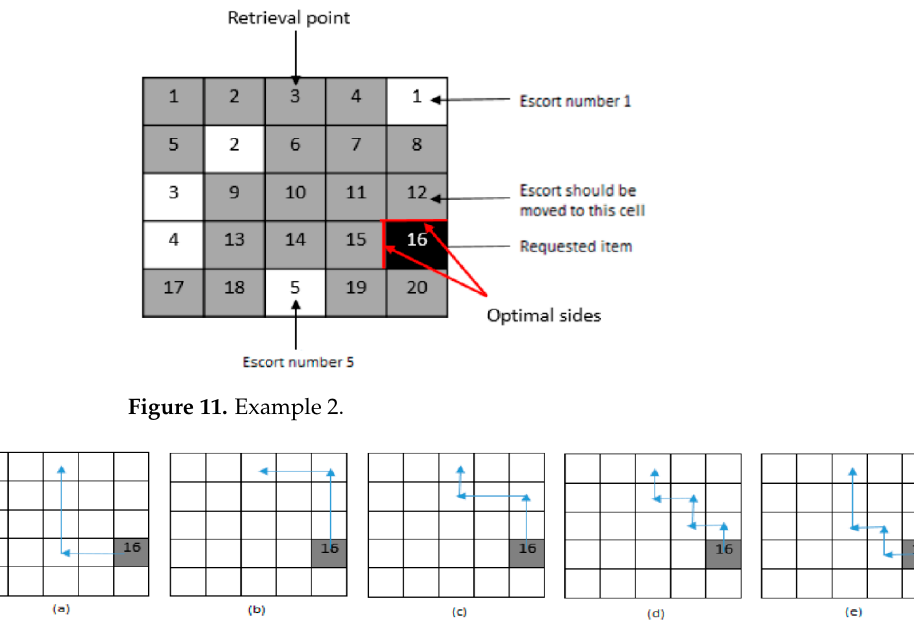
Figure 12. Possible path to retrieve the requested item in example 2. ( a ) Path a; ( b ) Path b; ( c ) Path c; ( d ) Path d; ( e ) Path e. Table 1. The required number of movements based on selected empty cell and path in example 2.